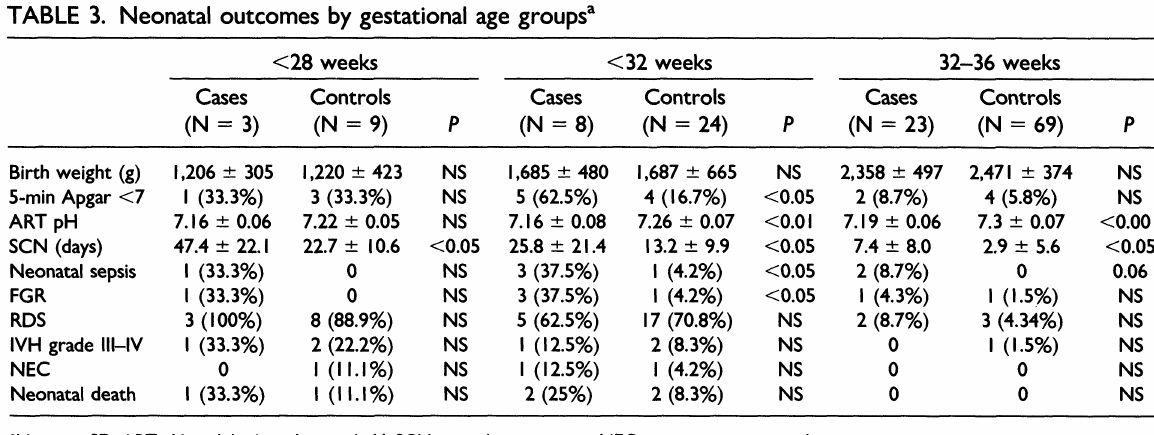
TABLE 3. Neonatal outcomes by gestational age groups